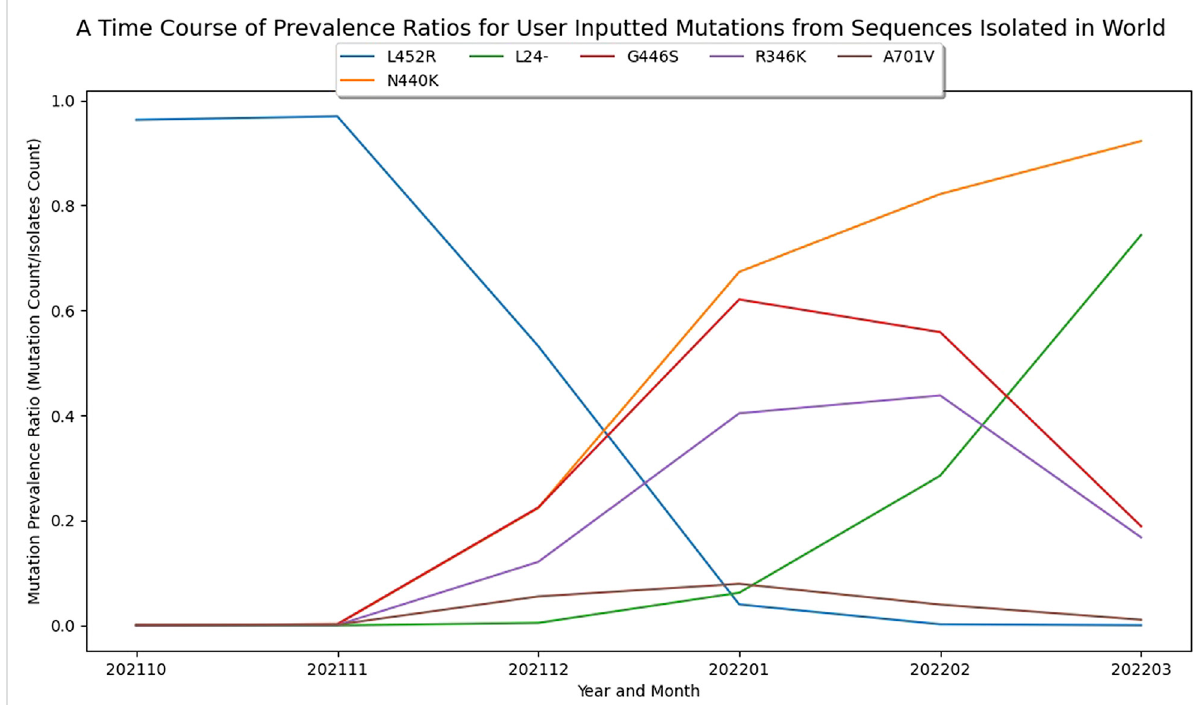
FIGURE 4 Visualizing Growth Patterns of Single Amino Acid Mutations in the Spike Protein. A plot based on GISAID data up to March 2022 demonstrating the shift in dynamics for individual amino acid mutations. This plot is based on six selected amino acid mutations. Note that the L24-is a part of an extended deletion that also includes P25 and P26 found in